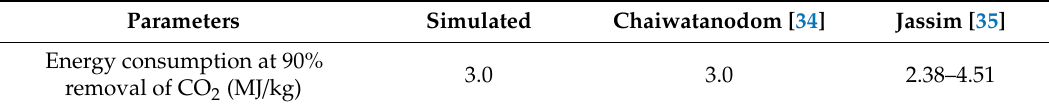
Table 3. Comparison of the monoethanolamine (MEA) model simulation with reported data. Parameters Simulated Chaiwatanodom [34] Jassim [35] Energy consumption at 90% removal of CO 2 (MJ /